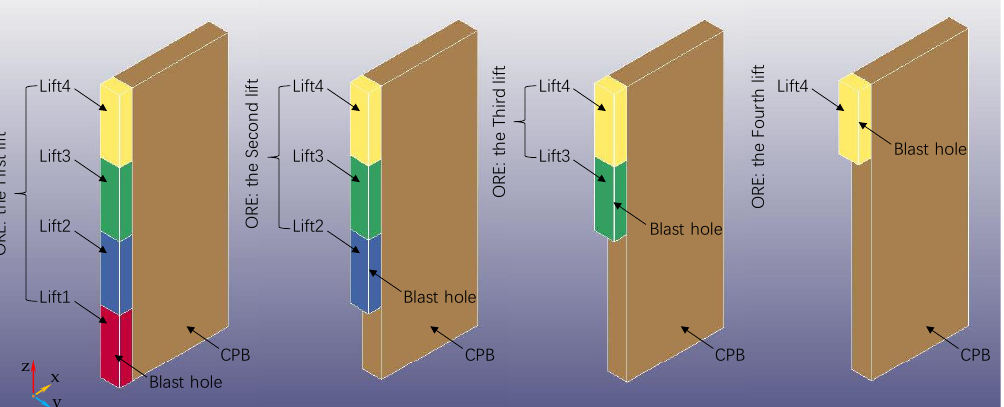
Figure 4. Lift blasting model for the primary stop: Lift 1 to Lift 4 are the ore materials in the secondary stope and will be blasted down in the cut process; the CPB stope is adjacent to the ore stope and will be affected by the explosive blasting in the ore stope.